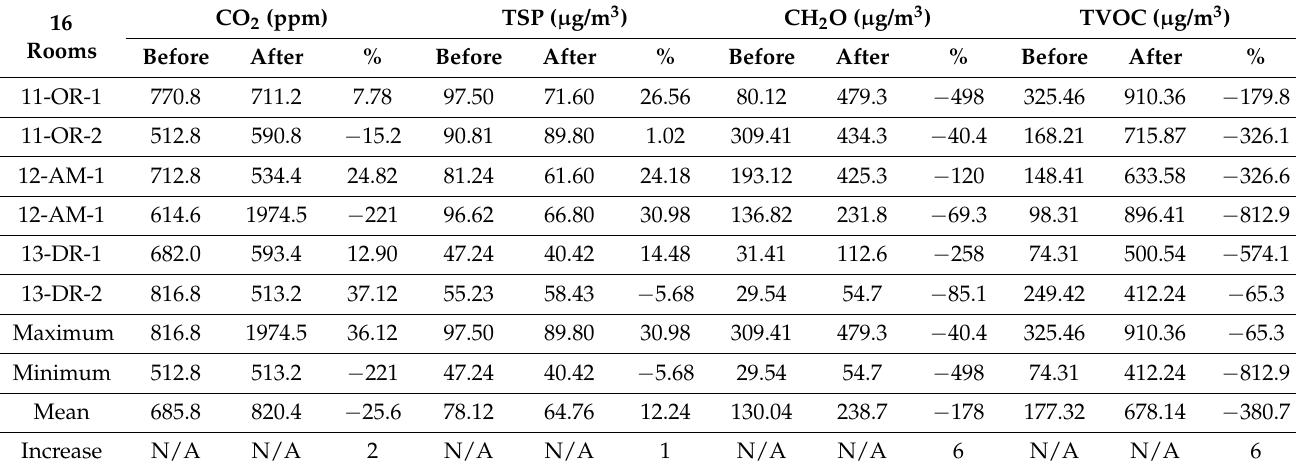
Table 5. Changes in indoor air pollutants before and after improvement with building material changes.